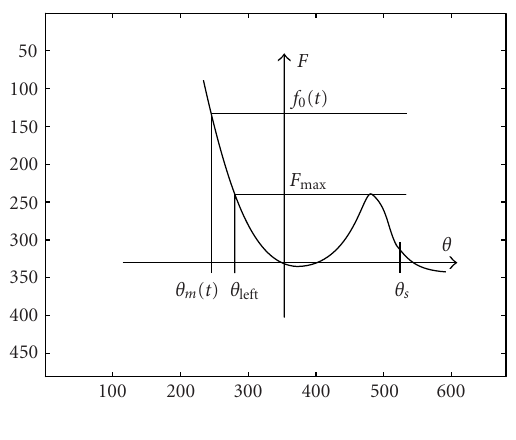
Figure 2.1. Determination of θ m ( t